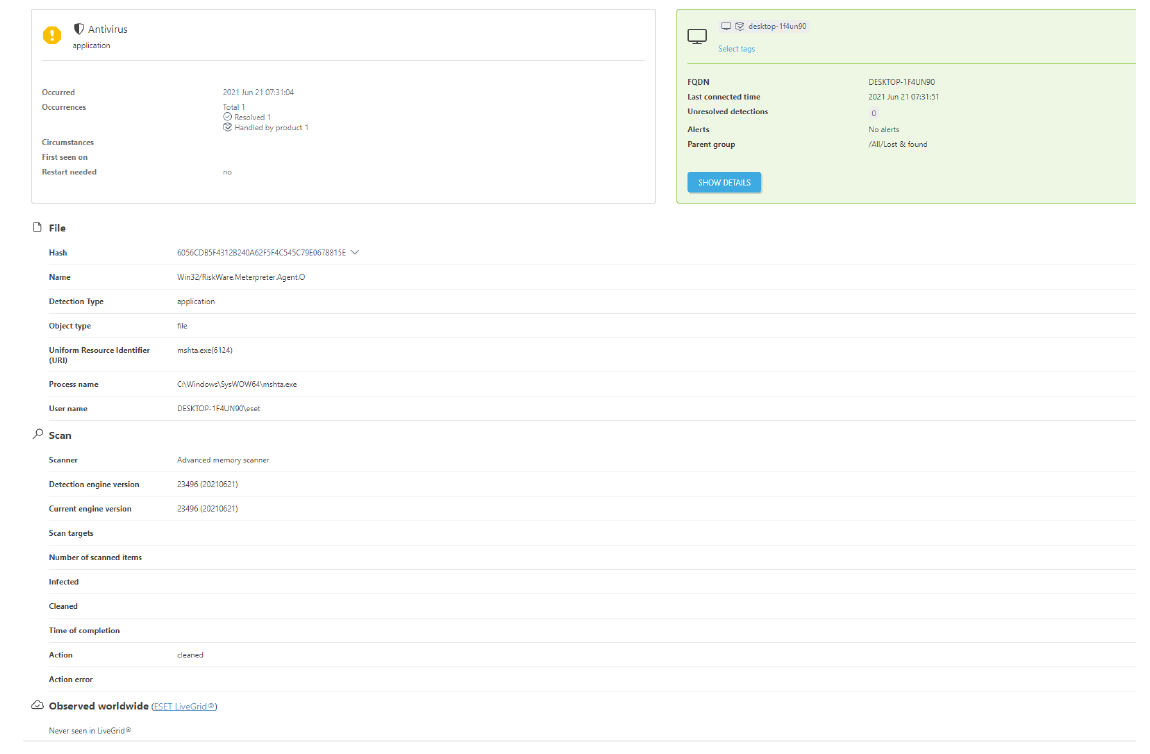
Figure 11. ESET PROTECT Enterprise detects the HTA attack.